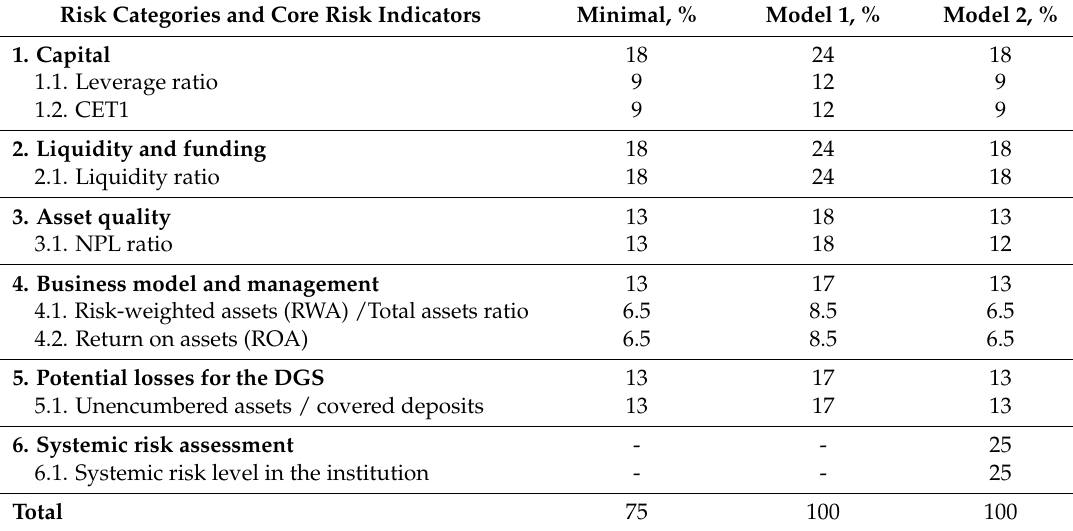
Table 3. Risk weights: Minimal, Model 1 and Model